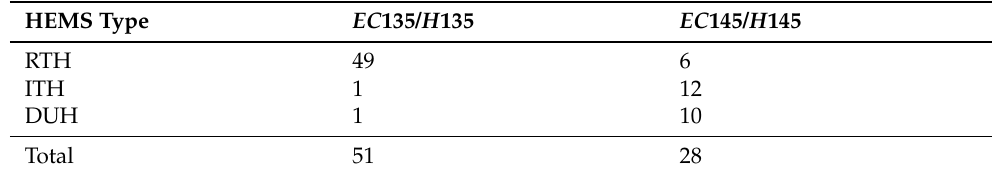
Table 1. German HEMS station